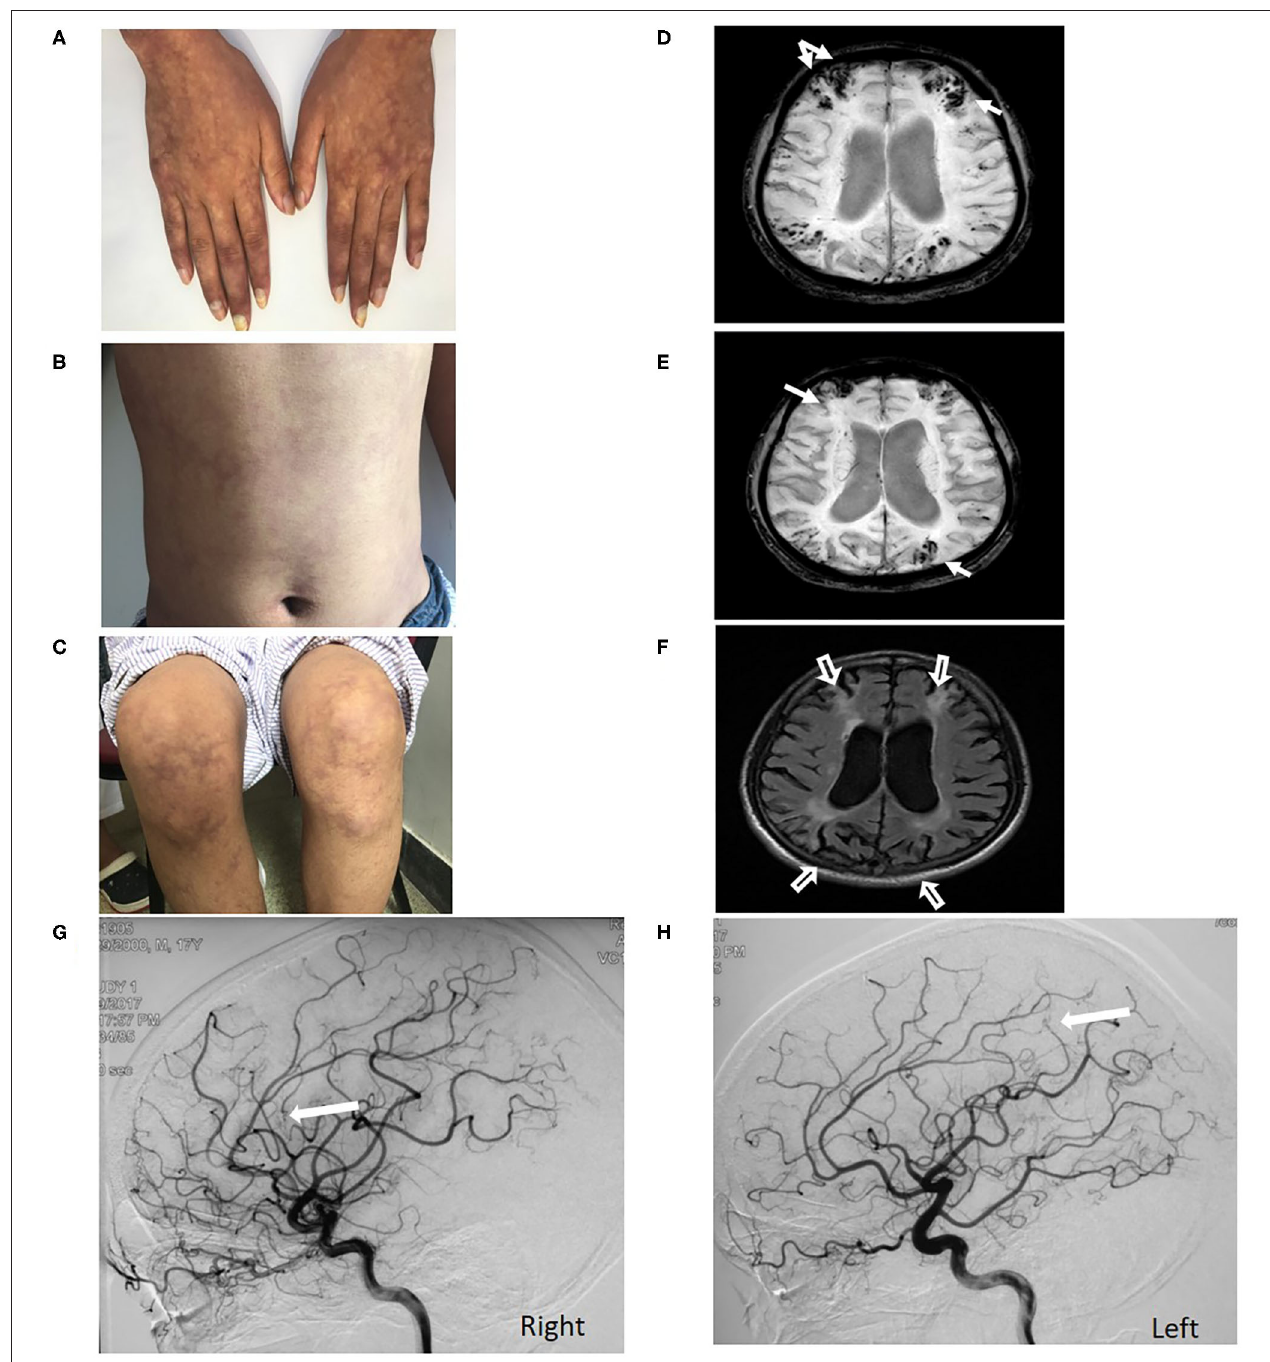
FIGURE 2 | Livedo reticularis of Case 4 over the hands, abdomen and leg (A–C) . Multiple microbleeds restricted in cortex and superficial siderosis (white arrow) located in the cortical watersheds are observed on SWI (D,E) . Significant cortical atrophy (hollow white arrow) in bilateral cerebral cortical watershed was observed in the context of a generalized cerebral atrophy on Flair sequence (F) . DSA shows filling defects (white arrow) in distal segments of bilateral MCA (G,H) .